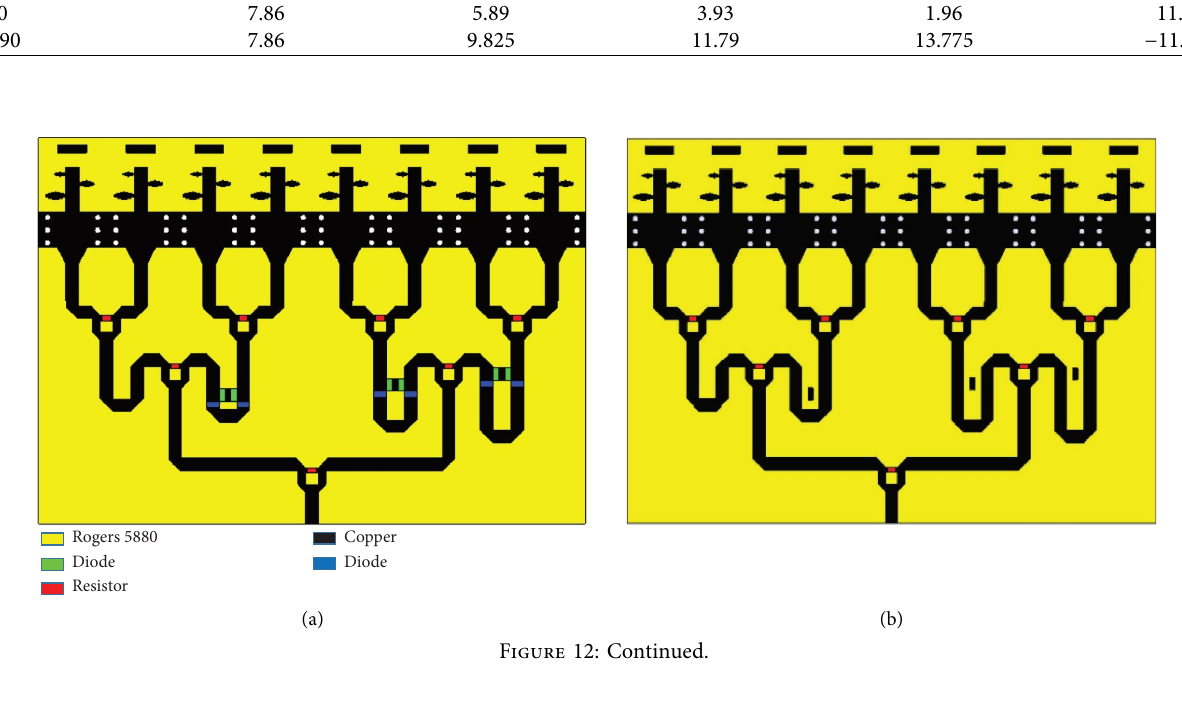
to L values for θ � 11 ° and θ � − 11 ° . 0 3